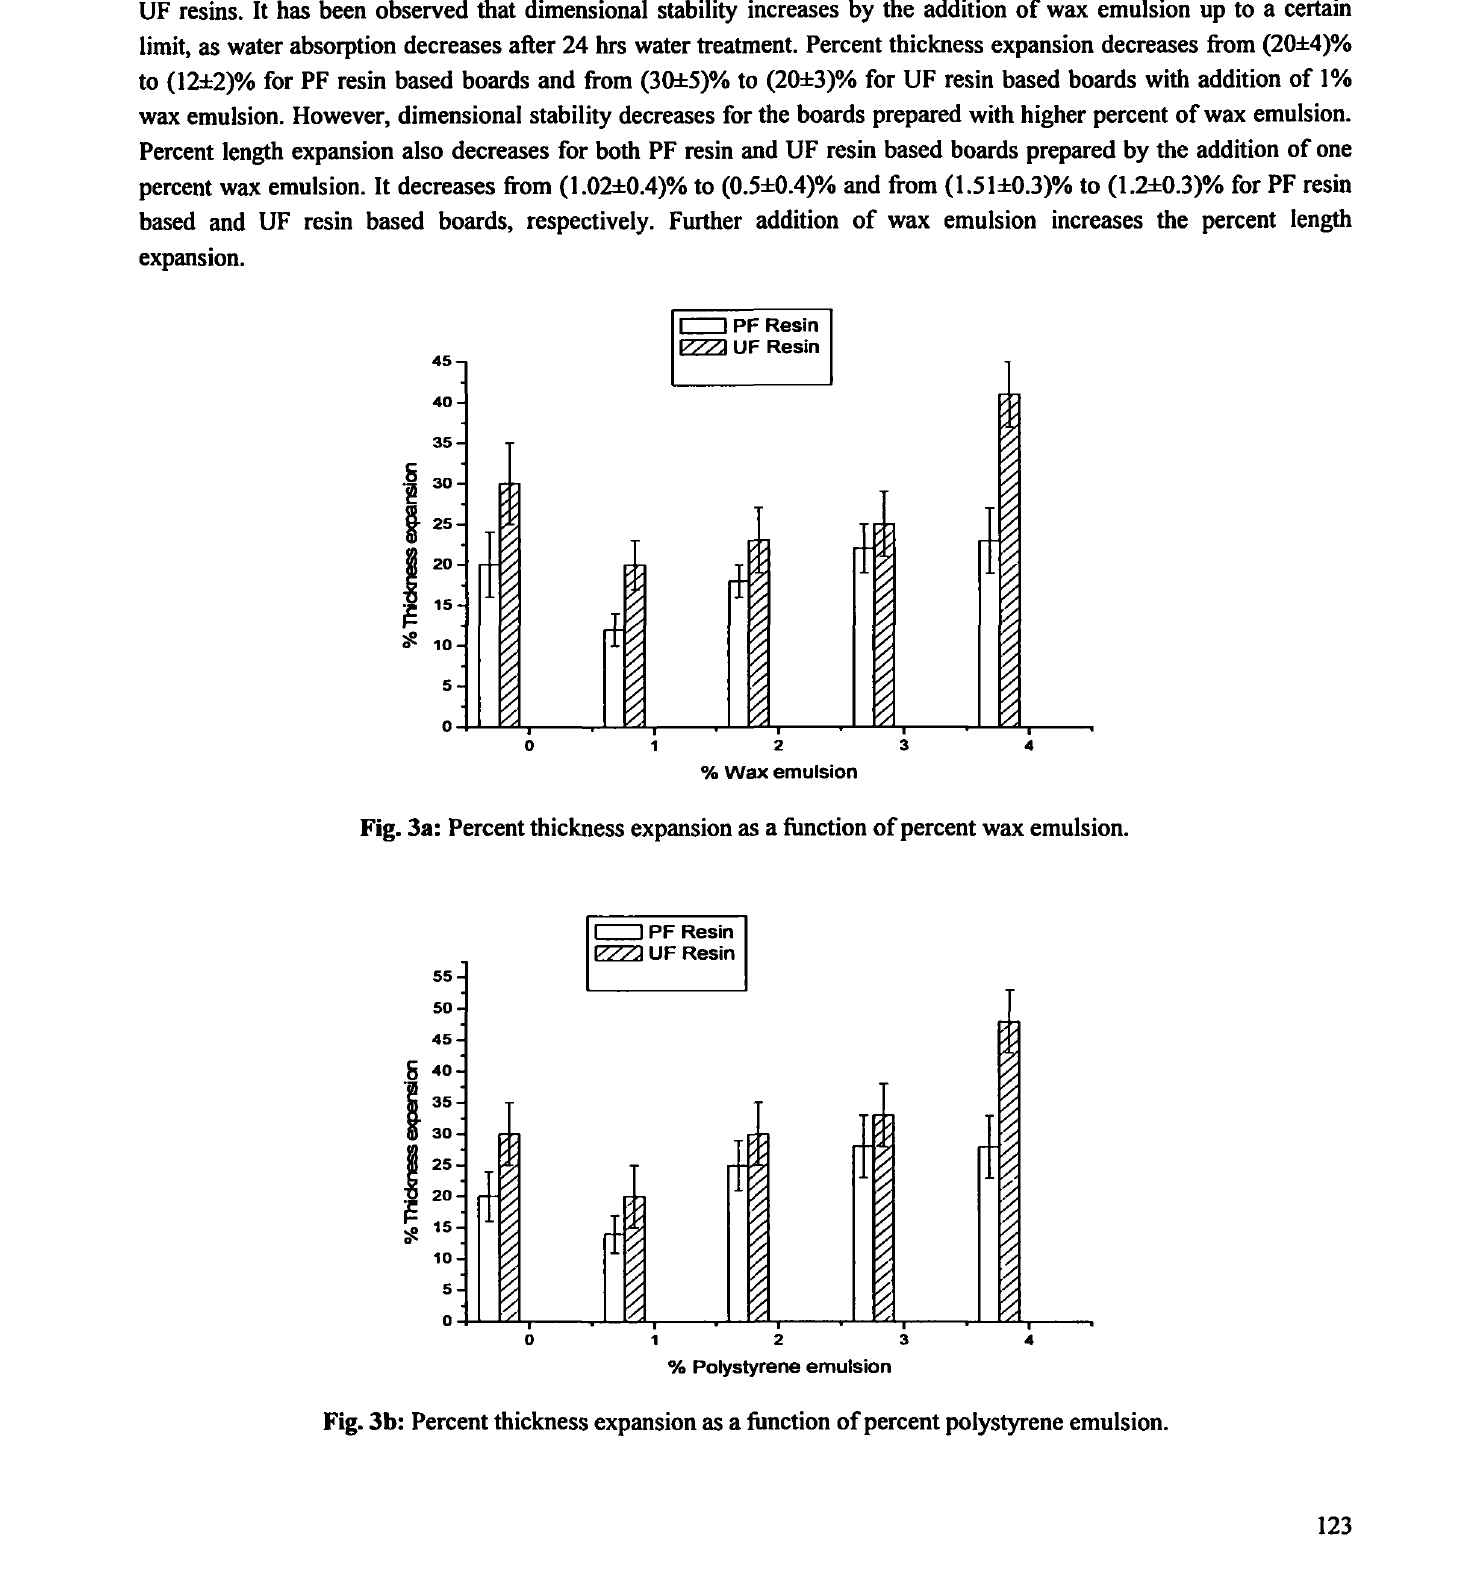
Fig. 3b: Percent thickness expansion as a function of percent polystyrene